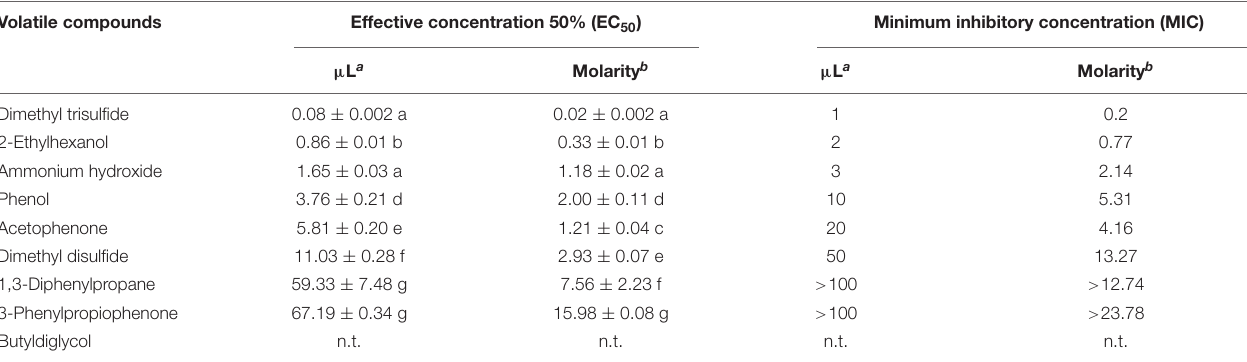
TABLE 2 | Experiment H. In vitro toxicity of synthetic volatile compounds against Heterobasidion abietinum